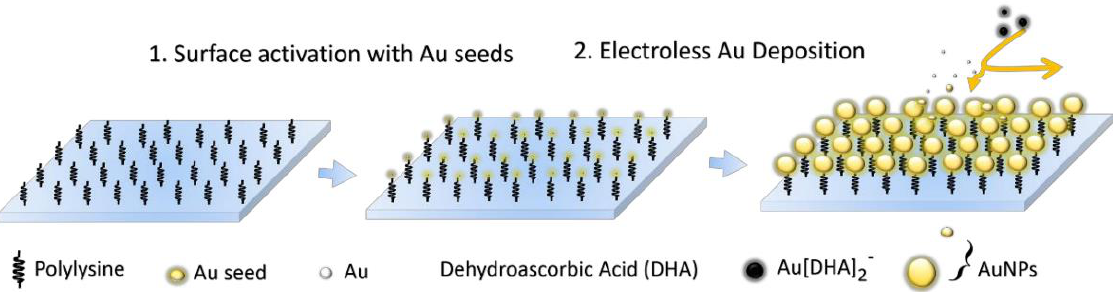
Figure 7. Schematic diagram of the synthesis of Au NPs films as uniform SERS-active substrates by the SMED approach [90].